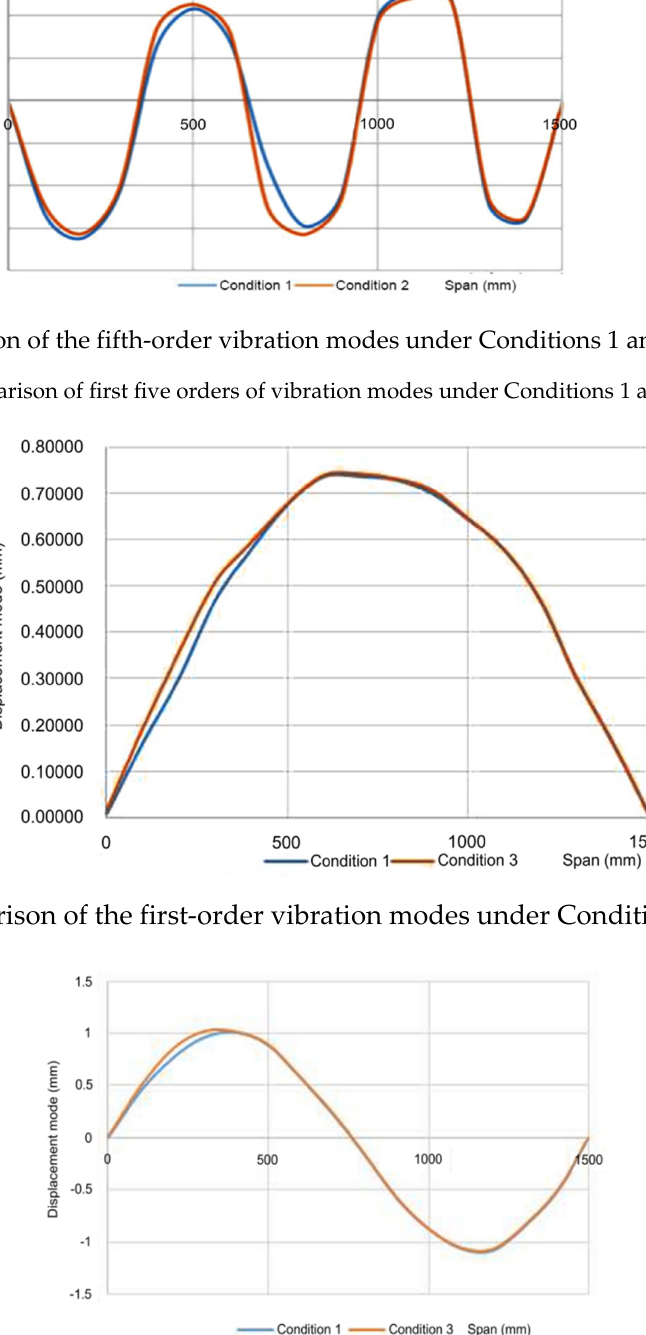
( b ) Comparison of the second-order vibration modes under Conditions 1 and 3. Figure 10. Cont